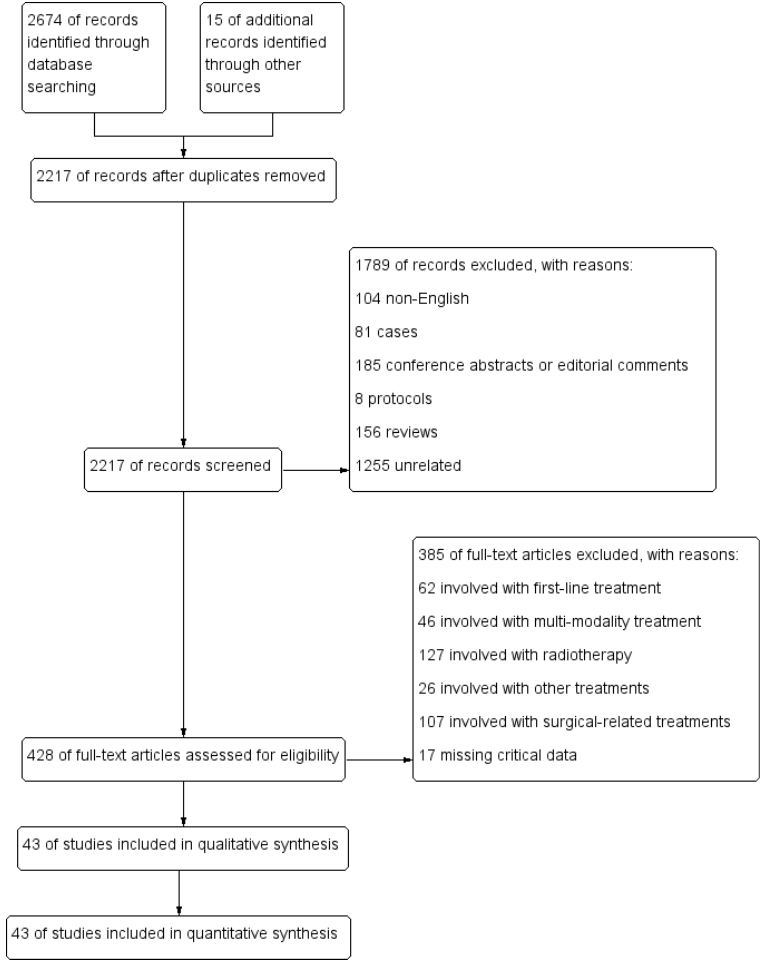
Figure 1. Flow diagram of article selection.